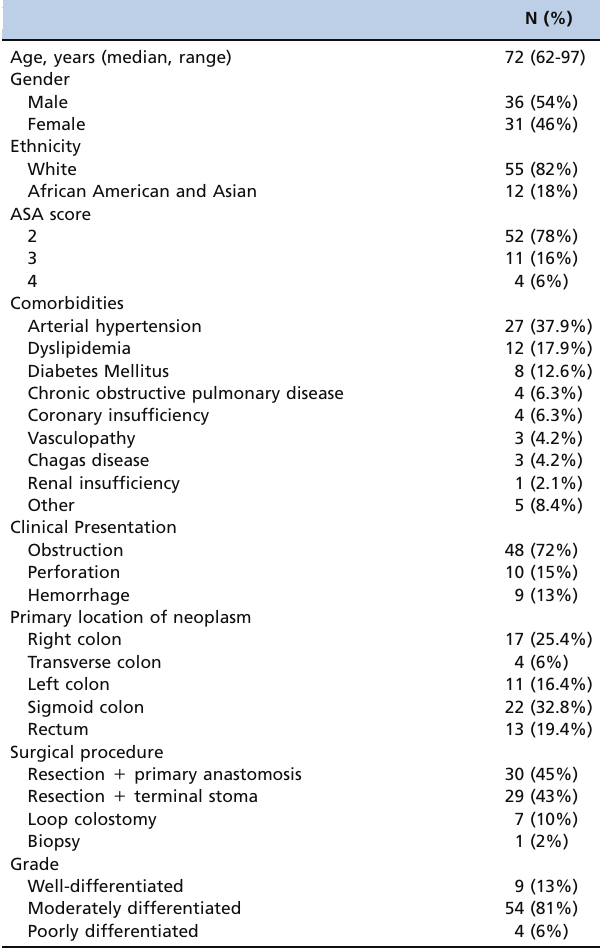
Table 1 - Demographic, clinical and pathological data of 67 elderly patients with